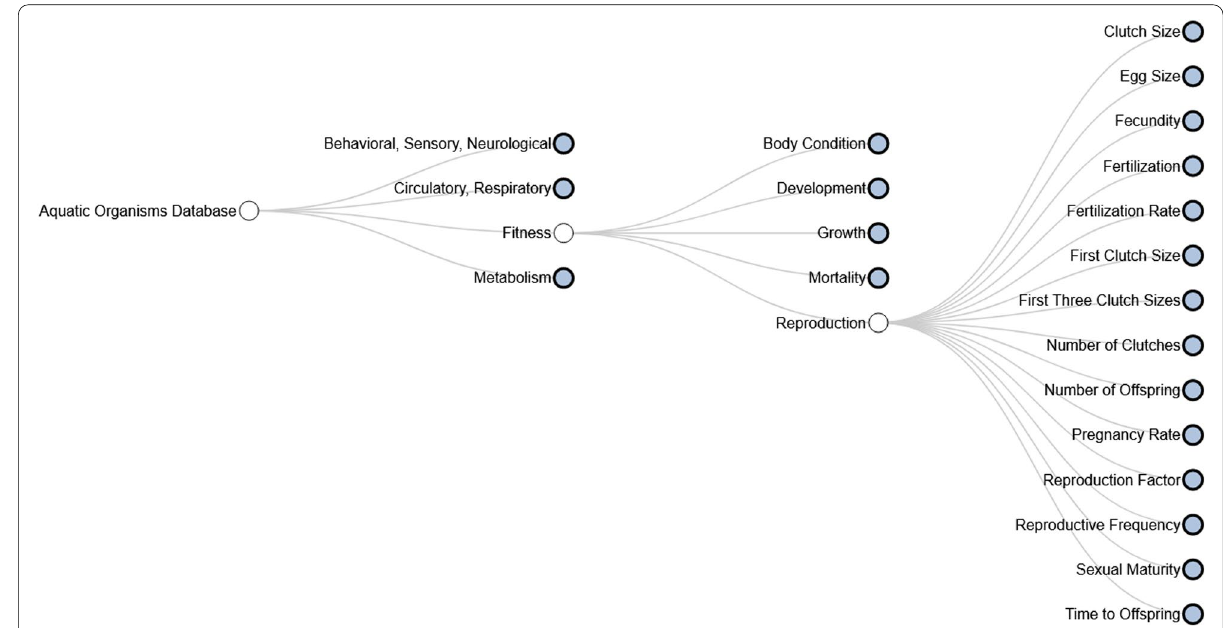
Fig. 1 Representative visualization of endpoint categorization within the database using the Overview